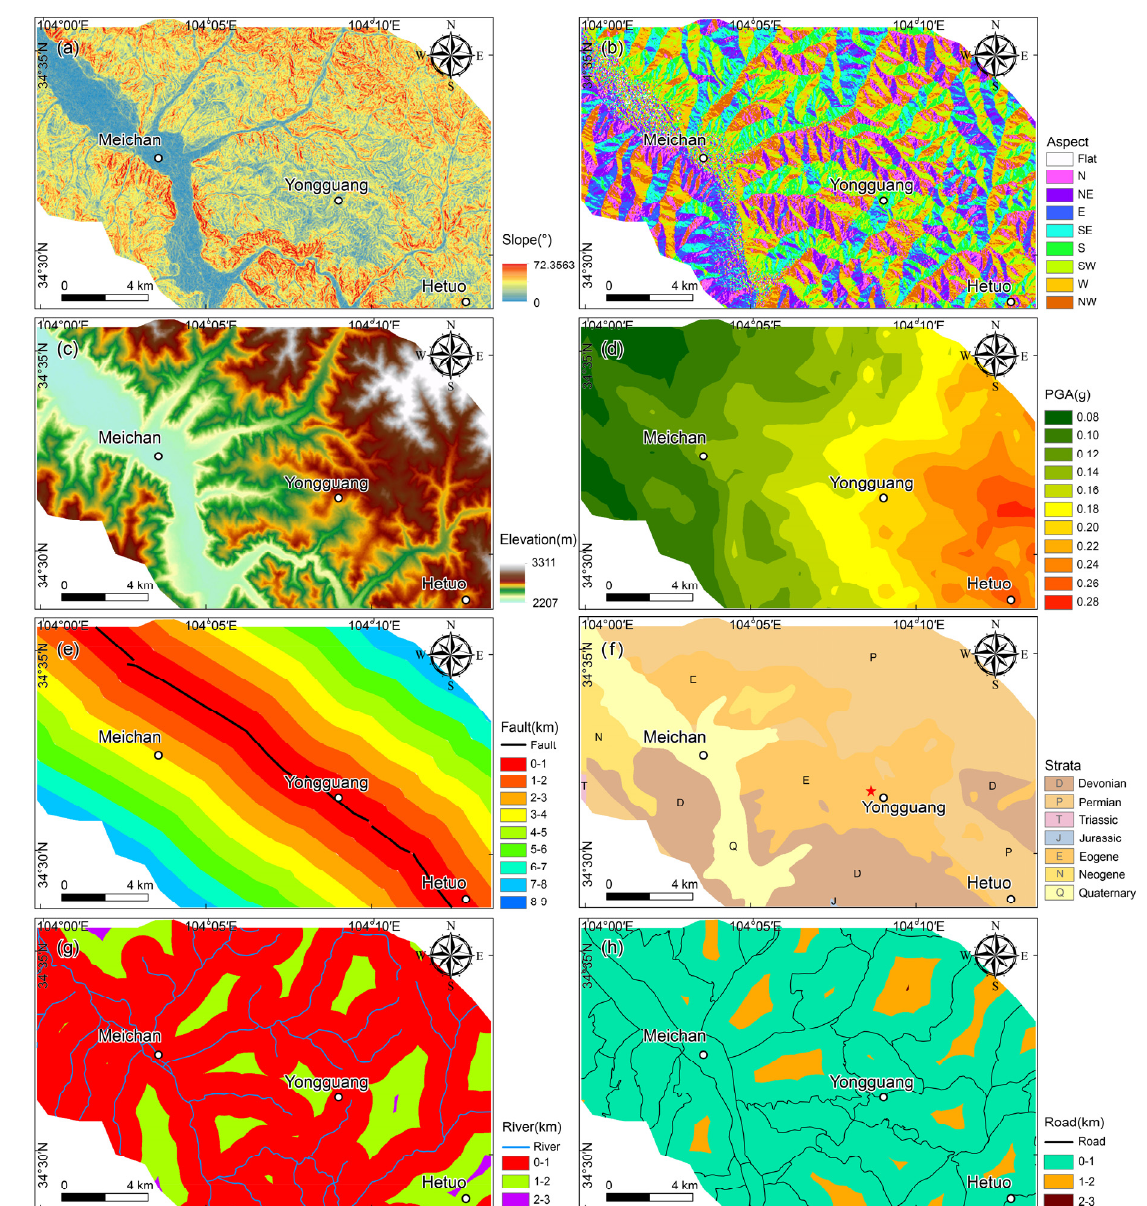
Figure 7. Influencing factors in Minxian. ( a ) Slope; ( b ) Aspect; ( c ) Elevation; ( d ) PGA; ( e ) Fault (The black line is the Hetuo fault [38]); ( f ) Strata (Red star near Yongguang village: outcrop in Figure 5c); ( g ) River; ( h ) Road.